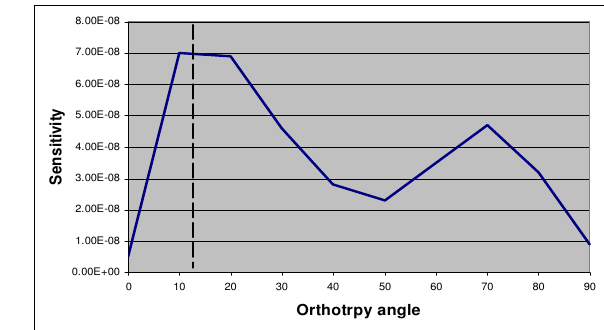
Fig 6. Approximated values of sensitivity of in-plane Poisson’s ratio to the orthotropy angle E- Carbon (square specimen) Material